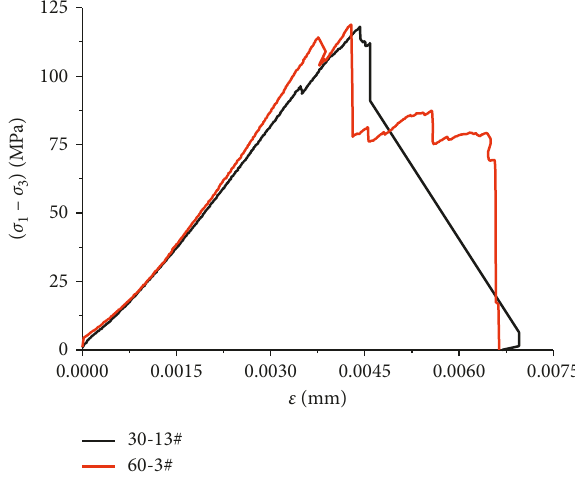
Figure 17: Stress-strain curves for specimens 30-13 and 60-3. Table 2: The brittleness of specimens 30-13 and 60-3 under each brittleness index.